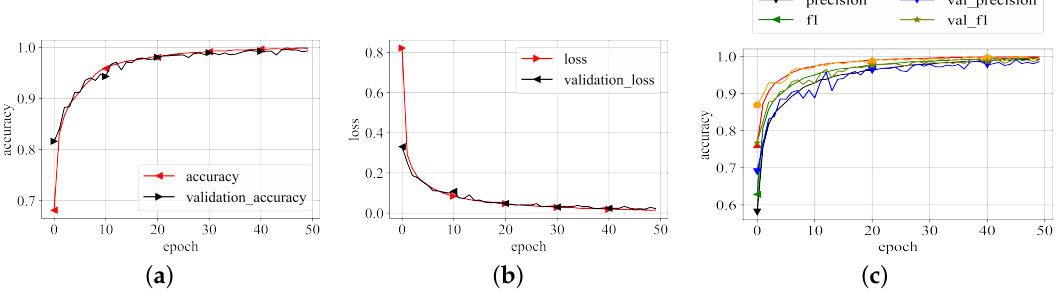
Figure 6. Training results. ( a ) Training accuracy; ( b ) Training loss; ( c ) P, R,